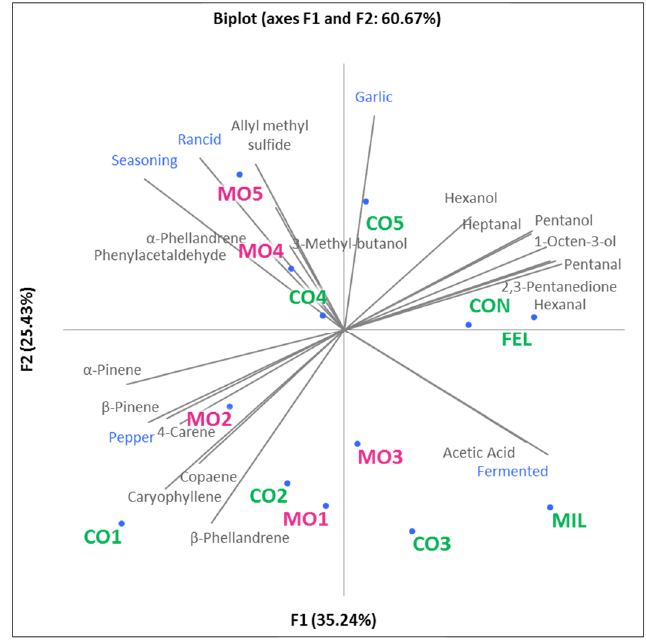
Figure 3. Projection of samples and variables (intensity and shades of red) on a plane (PCA). Samples from conventional breeds and Mora Romagnola samples are labeled in green and pink, respectively. Samples were coded as CO1 (conventional salami with small size), MO1 (Mora Romagnola salami with the same size as CO1), CO2 (conventional salami of “Nostrano” type), MO2 (Mora Romagnola salami similar to CO2), CO3 (conventional salami of “Cacciatore” type), MO3 (Mora Romagnola salami similar to CO3), CO4 (conventional salami obtained directly from a local producer), MO4 (Mora Romagnola salami similar to CO4), CO5 (conventional salami obtained directly from a local producer), MO5 (Mora Romagnola salami similar to CO5), CON (conventional salami of “Contadino” type), FEL (conventional salami of “Felino” (PGI) type), and MIL (conventional salami of “Milano” type).